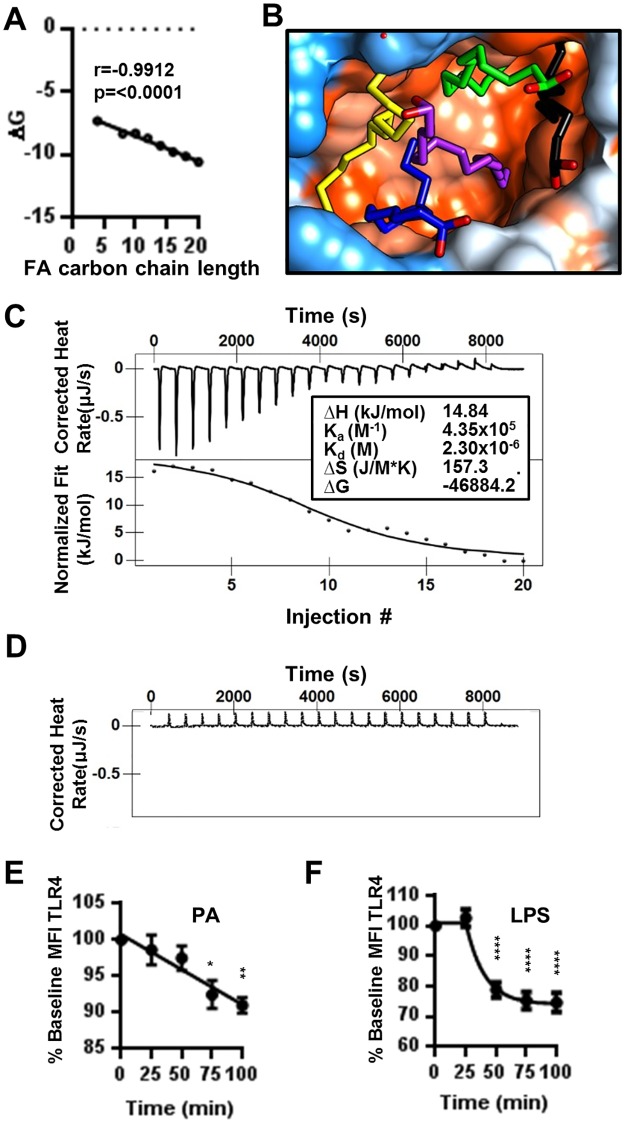
Palmitic acid is a ligand for TLR4/MD-2.(A) XY plot of fatty acid carbon chain length vs Gibbs free energy derived from docking FAs to MD-2 via the SwissDock server. (B) Molecular model of 5 PA docked in the hydrophobic binding pocking of MD-2. Orange color indicates hydrophobicity of MD-2 and blue indicates hydropholicity. Each PA molecule is in a solid color (yellow, black, blue, green, and purple) with oxygen atoms in red. (C) Isothermal titration calorimetry. Isotherms and fitted area curve of PA into TLR4/MD-2 titration. Insert contains thermodynamic parameters for PA and TLR4/MD-2 binding interaction. (D) Control isotherm of PA titrated into buffer. (E-F) PA induces the internalization of TLR4. MoDCs were treated with 300μM PA (E) or 10ng/mL LPS (F) for indicated time intervals. Cells were stained for flow cytometry. CD14-CD11chiHLA-DRhi cells were assessed for TLR4. Data is presented as the percentage of baseline Geometric MFI. N = 3. Graphs display the mean ± SEM. Statistical analysis was calculated based on One way ANOVA (** = p<0.01, *** = p<0.001, **** = p<0.0001).